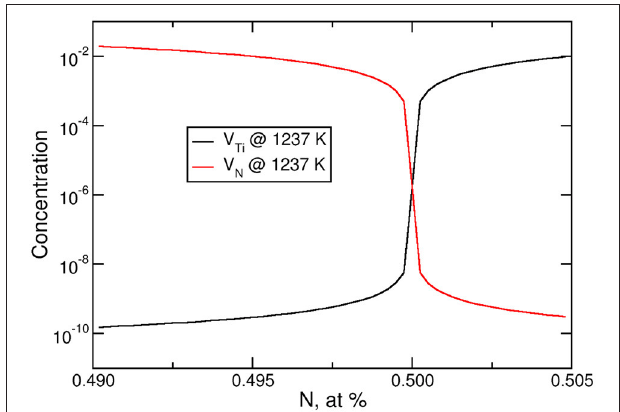
FIGURE 3 | Concentration of vacancies in TiN as a function of stoichiometry at 1,273 K.